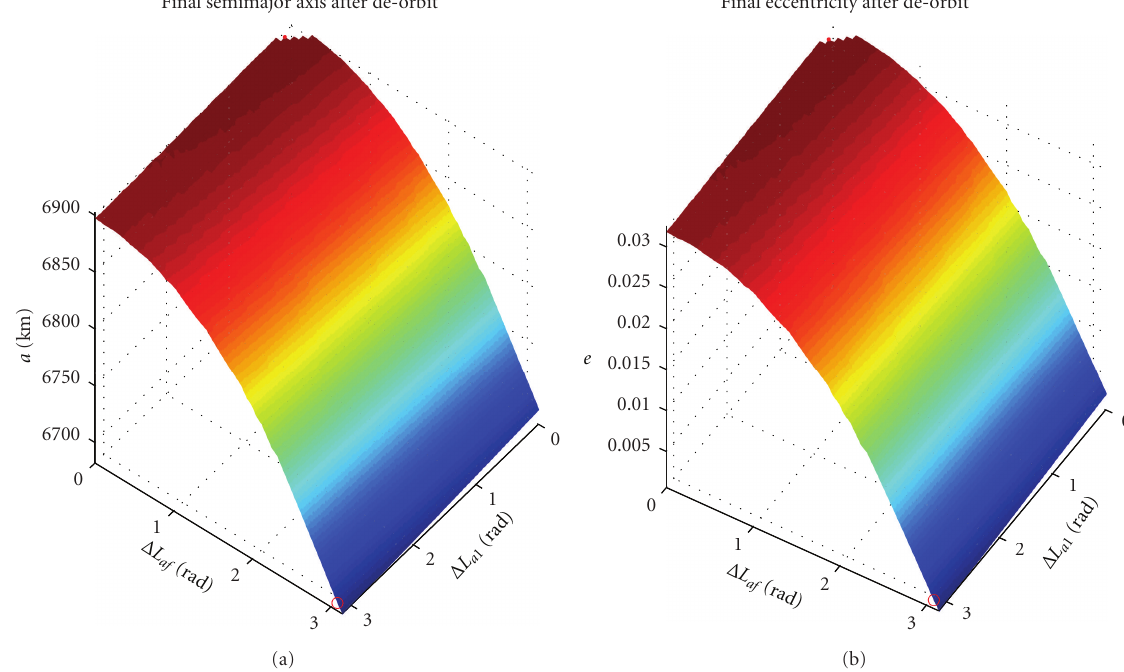
Figure 4: (a) final semi-major axis and (b) eccentricity after de-orbit with respect to Δ L a 1 and Δ L af for m IBS0 = 300 kg, a debr0 = 7128 km and m debr = 120 kg.